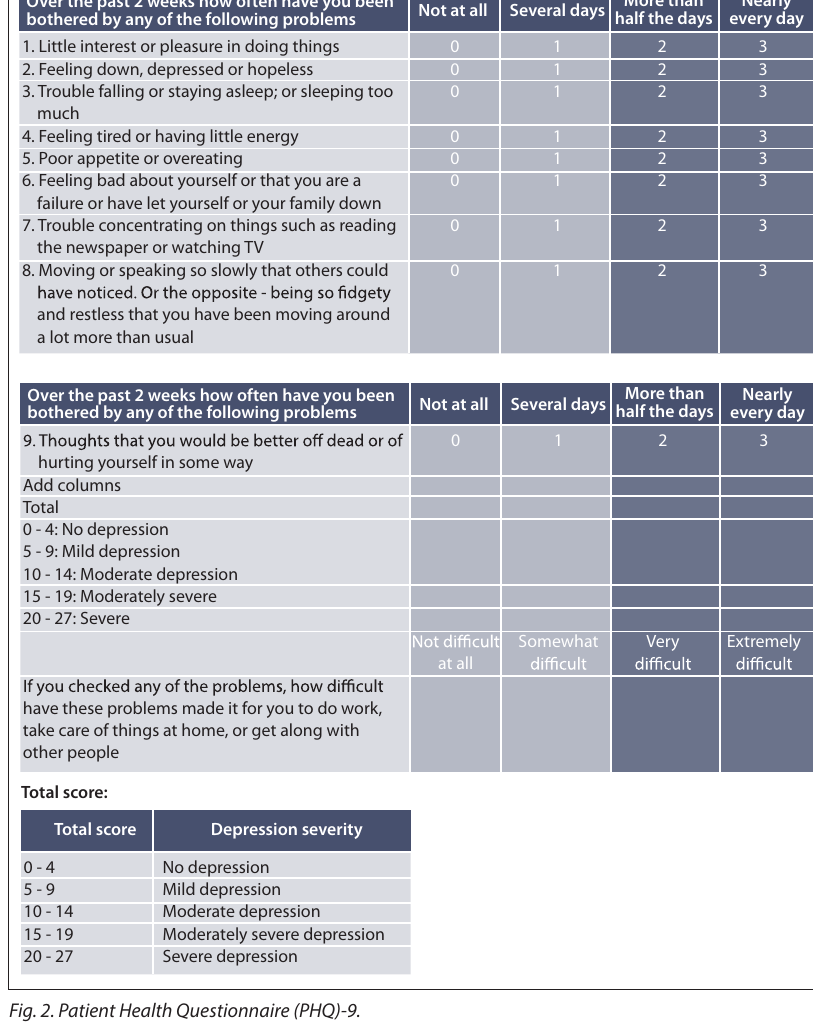
Fig. 2. Patient Health Questionnaire (PHQ)-9.